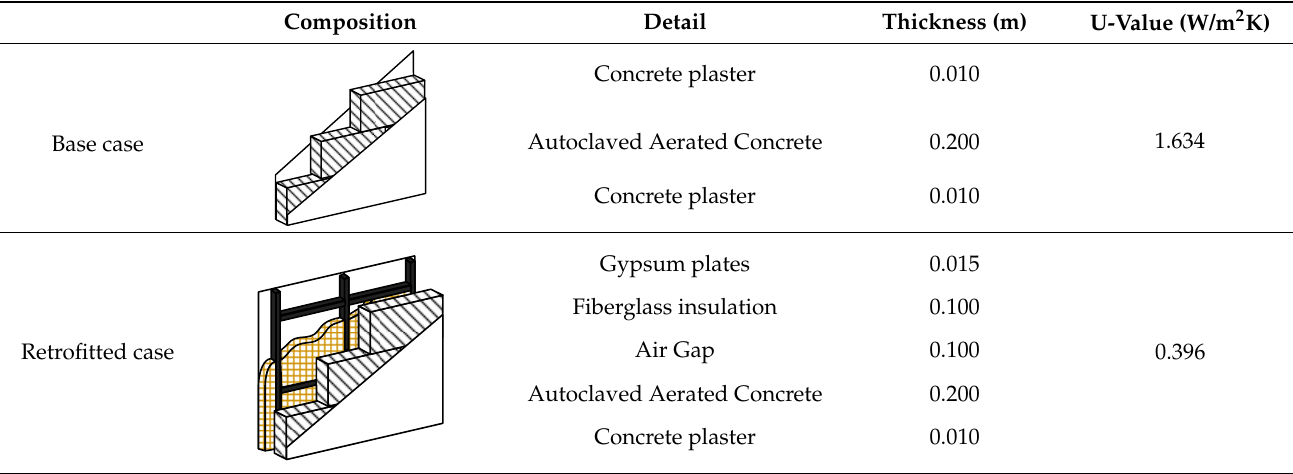
Table 7. Composition of opaque materials employed for the wall of the case-study building. U-value: thermal transmittance.